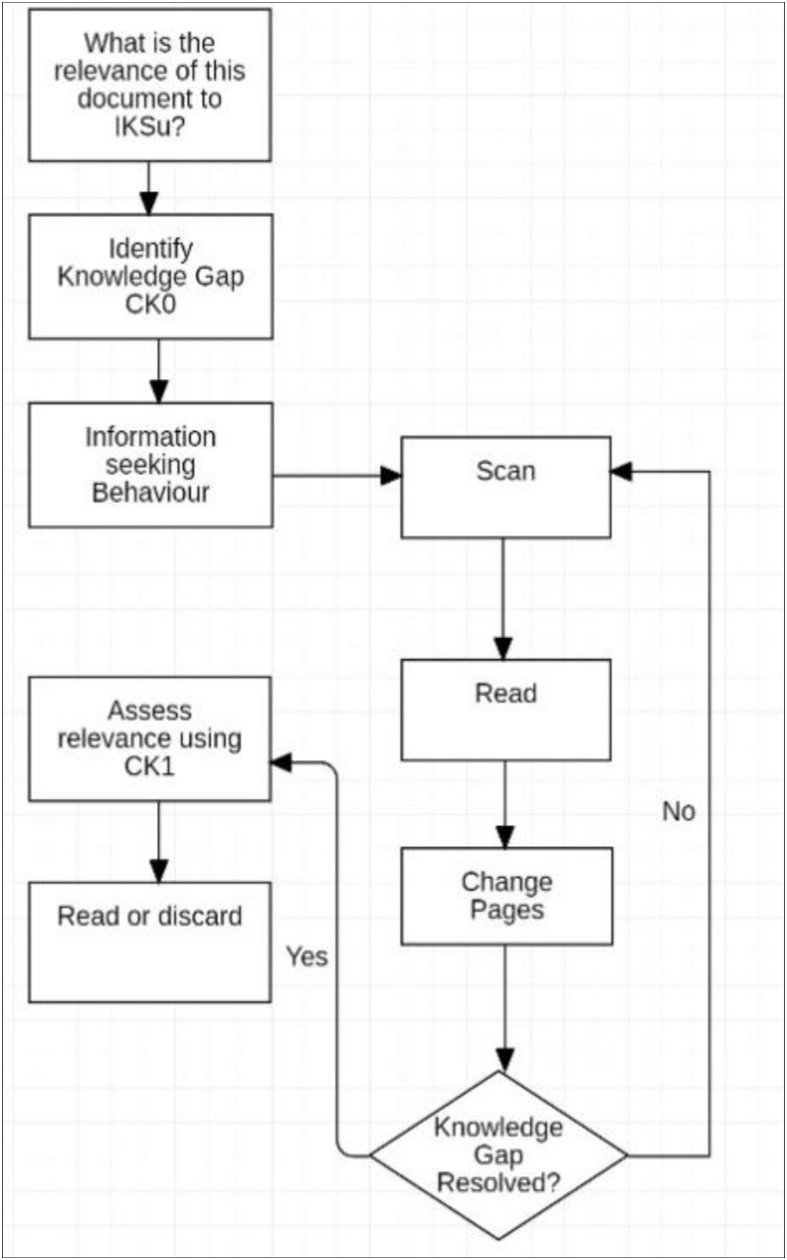
Decide relevance.